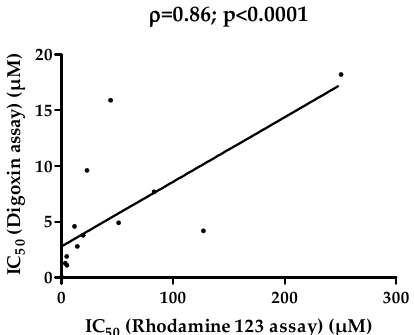
Figure 4. Correlation of IC 50 values for P-gp inhibition from rhodamine 123 assay and digoxin assay. IC 50 values towards P-gp activity for 14 drugs listed in Table 1, determined from rhodamine 123 accumulation assays and from digoxin bidirectional transport assays reported by Poirier et al. [41], were analyzed via the Spearman rank correlation method. Spearman coefficient ( ρ ) and p value are provided at the top of the correlation